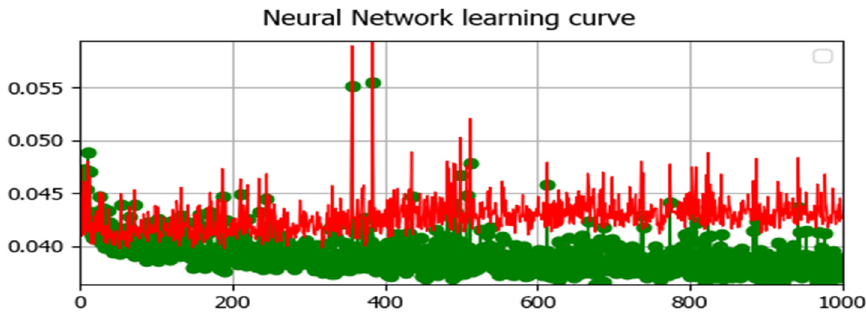
Figure 8. Neural network learning curve .